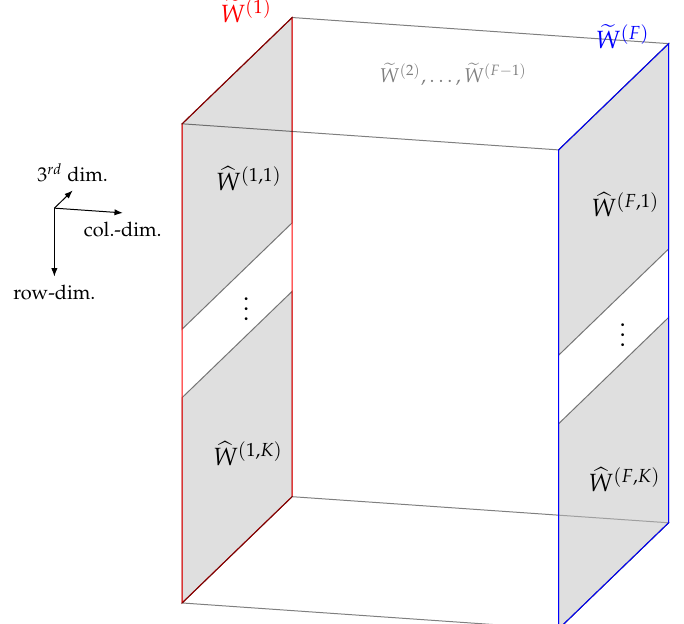
Figure 2. Tensor (cid:102) W obtained concatenating along the second dimension of the matrices (cid:101) W ( 1 ) , . . . , (cid:101) W ( F ) R nK × n . Before the concatenation, the matrices are reshaped as tensors in R nk × 1 × n ∈